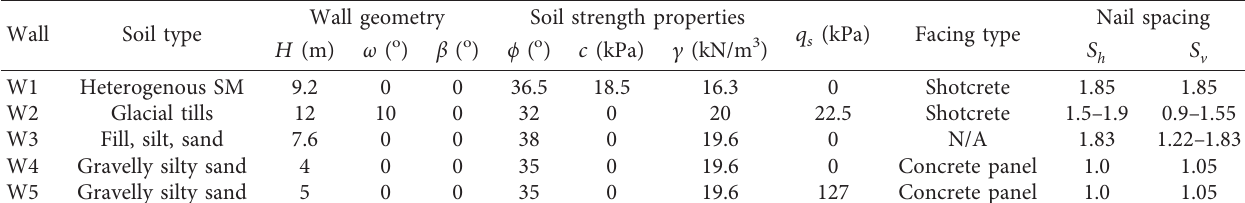
Table 2: Summary of wall geometry, soil properties, facing type, and nail spacing for soil nail walls.